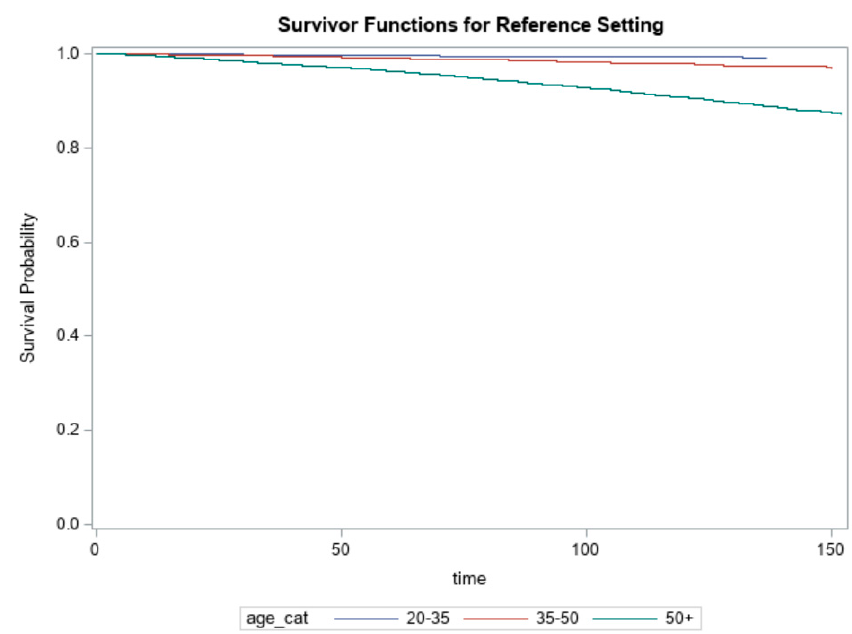
Figure 2. Survival probabilities across age groups.